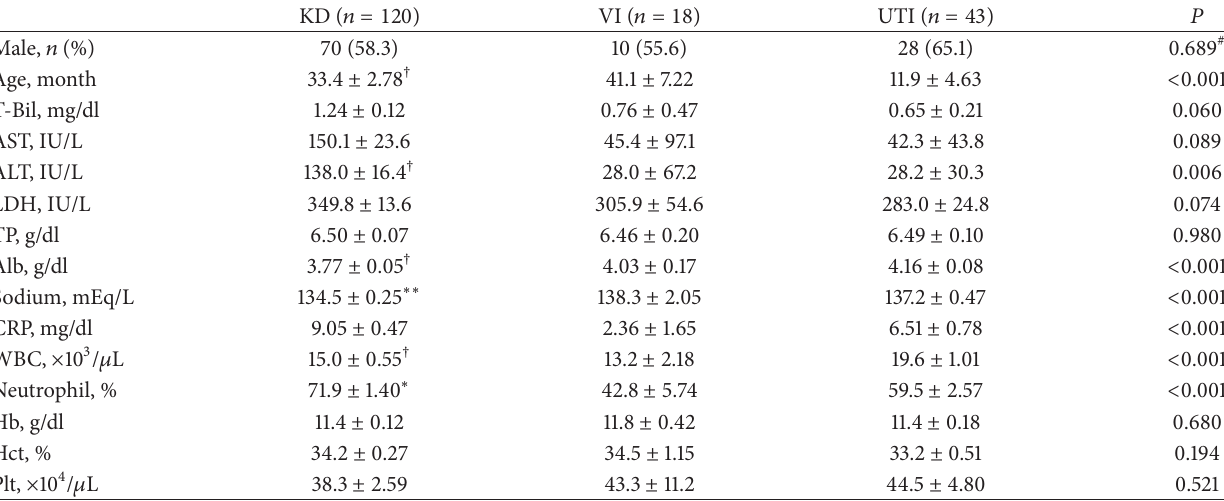
Table 1: A comparison of the clinical data among the KD, VI, and UTI